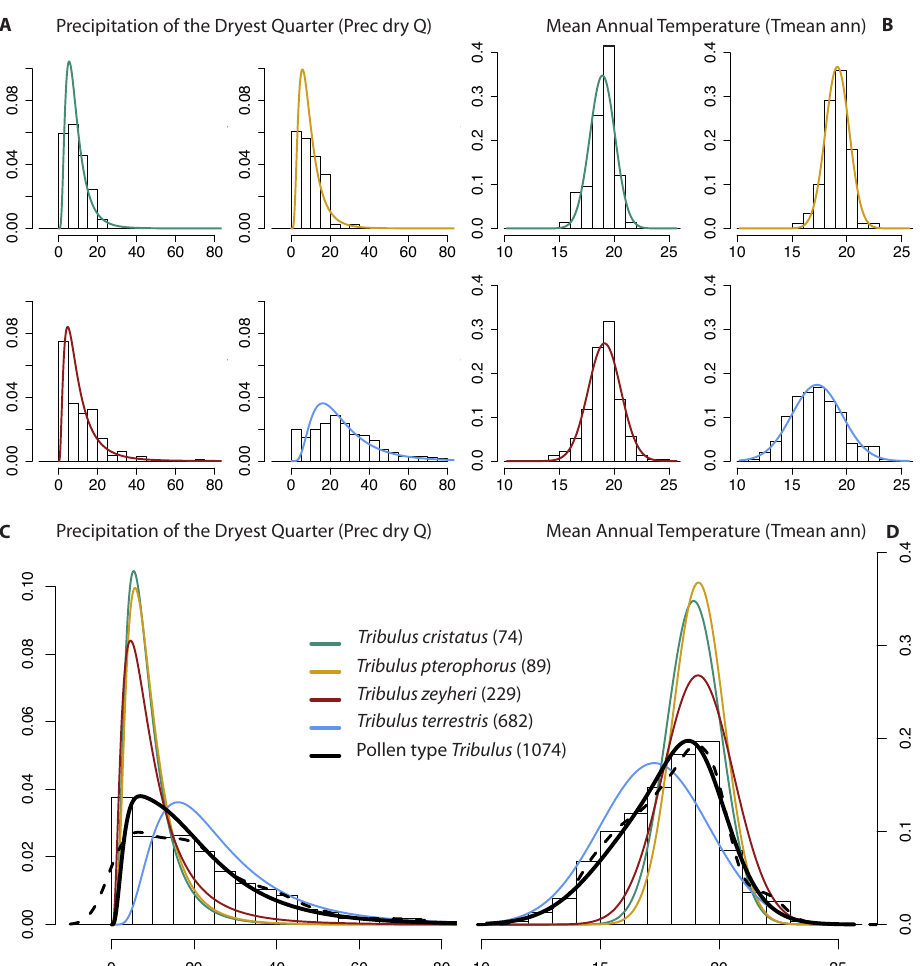
Figure 1. An example of PDF fitting for two variables (Prec dry Q and Tmean ann) for the pollen type Tribulus , which is composed of four species in our database. Four PDF sp ’s are then fitted for each variable ( a and b ) and combined to create the PDF pol ( c and d ). The dashed lines on (c) and (d) are the PDFs obtained by Truc et al. (2013). The difference between the two methods is more marked for prec dry Q, where (i) the PDF pol is null for negative precipitation values (more realistic) and (ii) the optimum is more marked and reflects the optima of the different